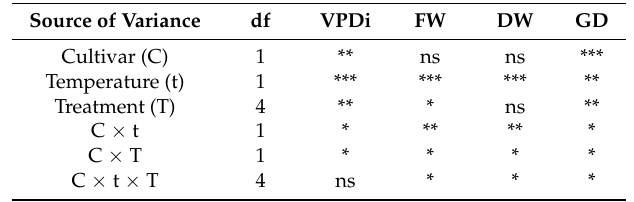
Table 2. Effects of temperature and pre-sowing seed treatment (two-way ANOVA) on vegetative phase development index (VPDi), fresh (FW) and dry weight (DW) of shoots and generative development (GD) of two L. angustifolius cultivars grown for the first four weeks at 7 ◦ C or 13 ◦ C from seeds three-hour hydroprimed or treated with 10 − 6 M, 10 − 5 M or 10 − 4 M butenolide.